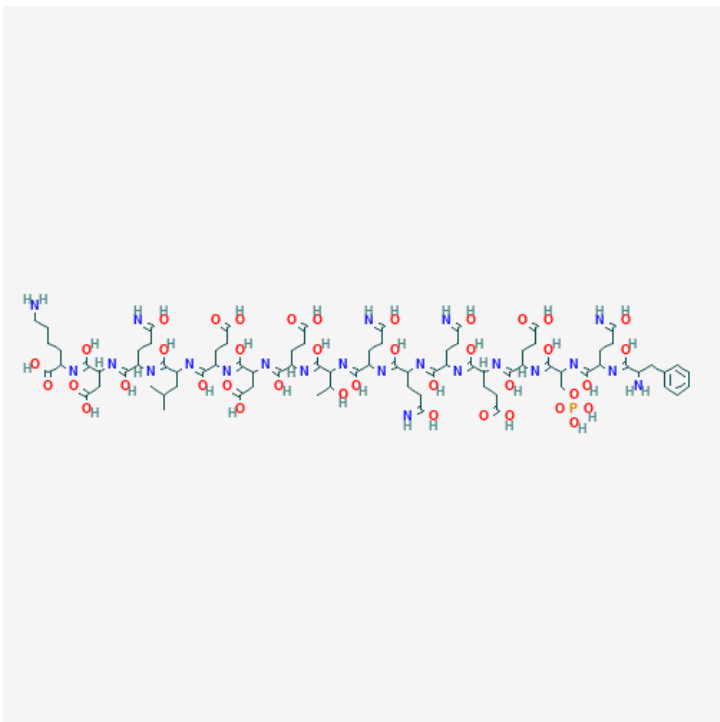
Figure 1. 2D structure of casein (https://pubchem.ncbi.nlm.nih.gov/ (accessed on 27 July 2021)). Casein-based blends with other biopolymers are generally prepared to improve